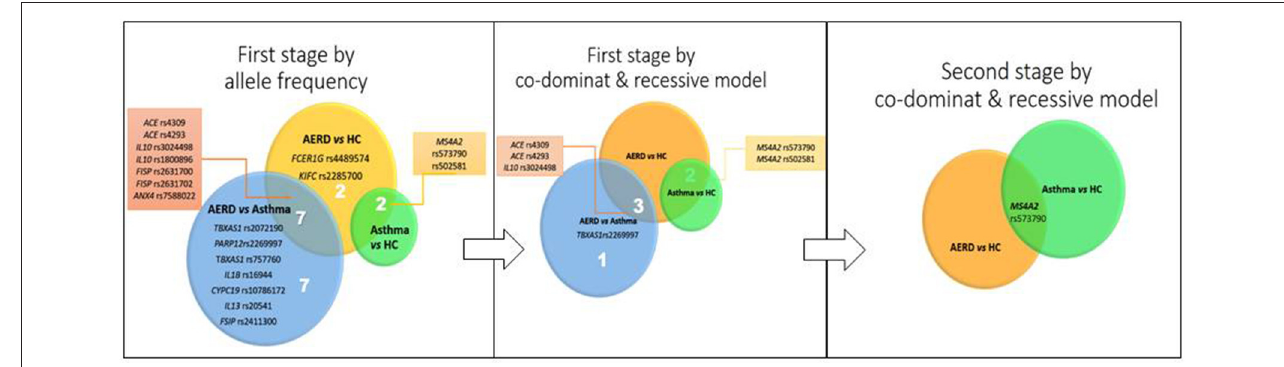
FIGURE 4 | Sequence of result analysis according to